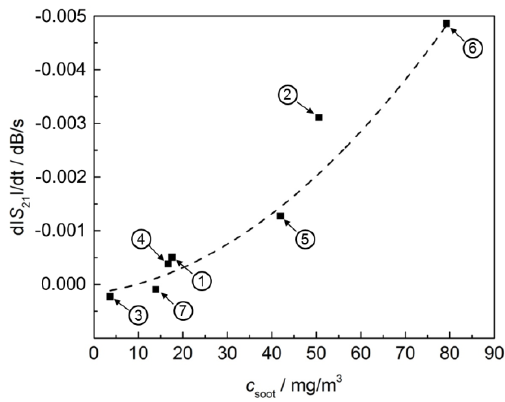
derivative of the frequency-averaged transmission parameter | S 21 | is plotted against the averaged soot mass concentration in the exhaust gas, measured with the Pegasor sensing device. Each point in Figure 8 is a result from one of the operation points ① to ⑦ .